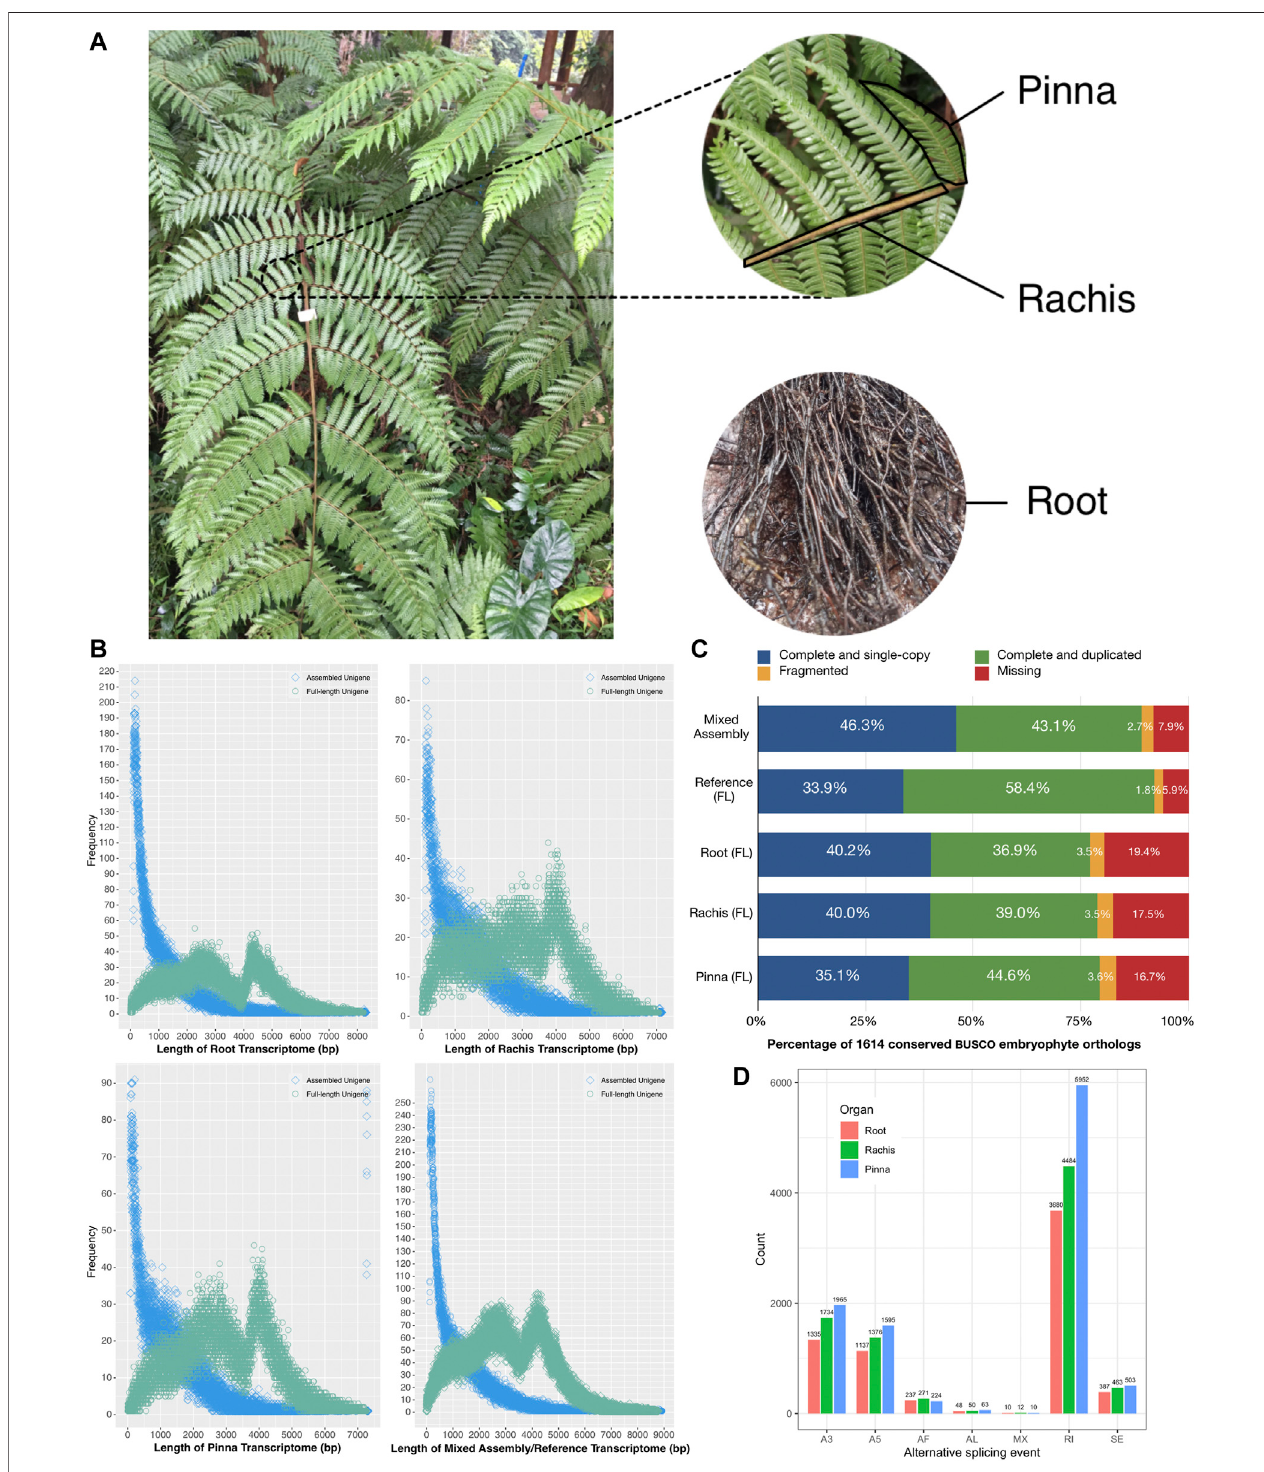
FIGURE 1 | Schematic diagram of Alsophila spinulosa transcriptome quality assessment via visualizing length distribution, BUSCO evaluation, and AS events detection. (A) Schematicdiagramofroot,rachis,andpinnaof A.spinulosa . (B) Frequencyofunigeneslengthintheroot,rachis,pinna,mixedassembly,andFLreference transcriptomes. (C) BUSCO evaluation of the root, rachis, pinna, mixed assembly, and FL reference transcriptomes. (D) The number ofseven types ofAS event in three organs.